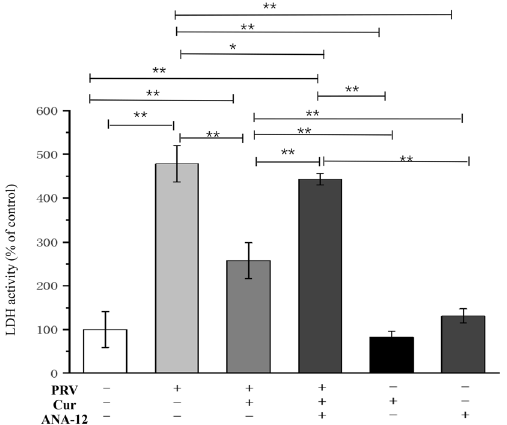
Figure 4. Blocking the BDNF receptor TrkB reversed the neuroprotective effects of curcumin. n = 3, represents three biological replicates, each performed in triplicate. Cur curcumin, BDNF brain-derived neurotrophic factor, TrkB tropomyosin-related kinase B. *P < 0.05; **P < 0.01, based on one-way analysis of variance (ANOVA) followed by least significant difference (LSD) post hoc test for multiple comparisons. “+” means added, “−” means not added.